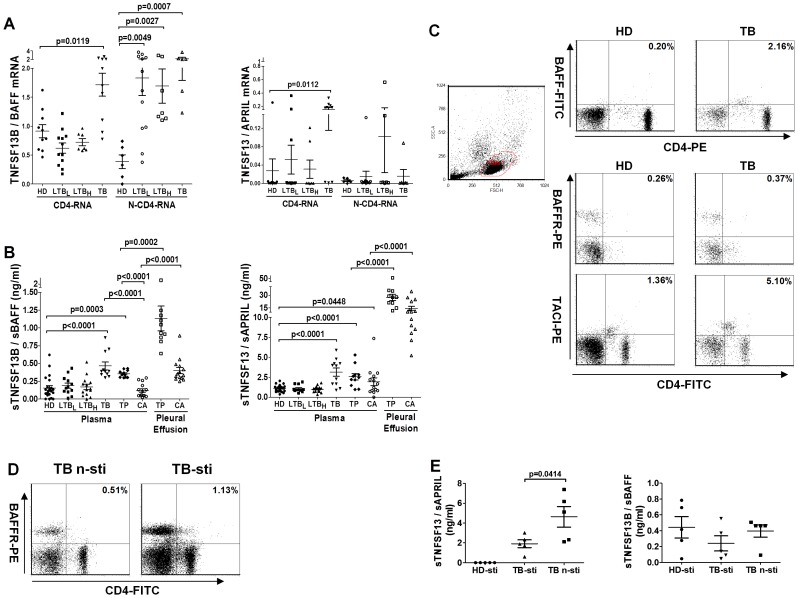
Detection of the BAFF/APRIL system-related genes.
A. BAFF and APRIL mRNA were detected in both peripheral CD4+ T cells (CD4-RNA; HD, n = 10; LTBL, n = 12; LTBH, n = 7; TB, n = 10) and CD4+ T cell-depleted PBMCs (N-CD4-RNA; HD, n = 6; LTBL, n = 12; LTBH, n = 7; TB, n = 6). The gene expression levels of BAFF and APRIL were normalized to β-actin. B. Soluble BAFF (sBAFF) and APRIL (sAPRIL) were measured by ELISA in plasma (HD, n = 22; LTBL, n = 12; LTBH, n = 14; TB, n = 11; TP, n = 11; CA, n = 14) and pleural effusion (TP, n = 10; CA, n = 14). C. Flow cytometry was employed to detect BAFF, BAFFR and TACI expression on the surface of peripheral CD4+ T cells from HD participants (n = 2) and TB patients (n = 2). D. M.tb antigen stimulation slightly augmented the frequency of BAFFR+CD4+ T cells in PBMCs from TB patients (TB-sti, n = 2) compared with un-stimulated cells (TB n-sti, n = 2). E. With or without M.tb antigen stimulation, the levels of sBAFF and sAPRIL were detected by ELISA in the supernatants of PBMCs from TB patients (n = 5). The stimulated supernatants of PBMCs from the HD group (n = 5) were used as a control. HD-sti: M.tb antigen-stimulated PBMCs from HD participants; TB-sti: M.tb antigen-stimulated PBMCs from TB patients; TB n-sti: un-stimulated PBMCs from TB patients.